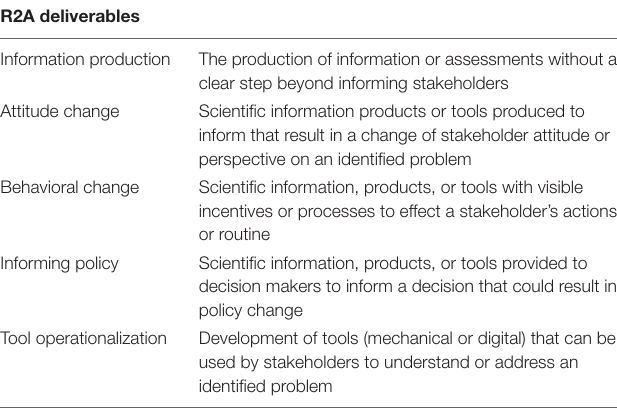
TABLE 1 | Five common research to application (R2A) project deliverables, identified and categorized from interview data. R2A